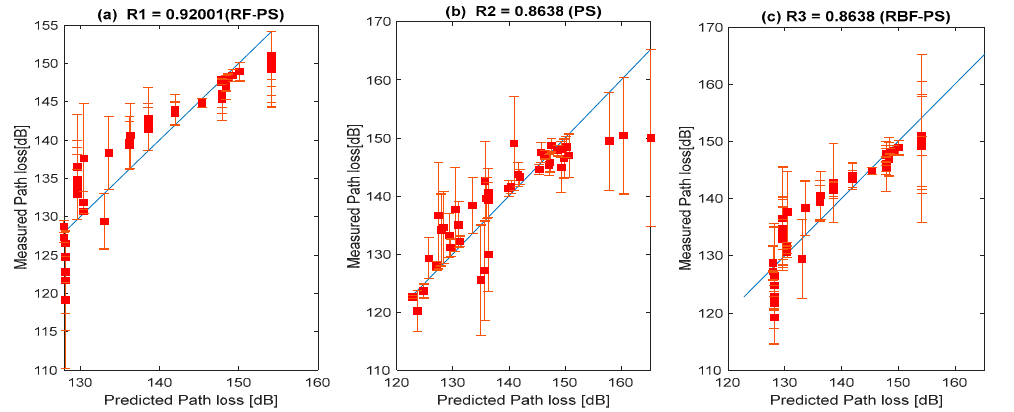
Figure 22. Results showing the correlation between the measured path loss and predicted path loss using the hybrid RF-PS prediction method and two existing standard path loss prediction methods in site 3 of location 1.